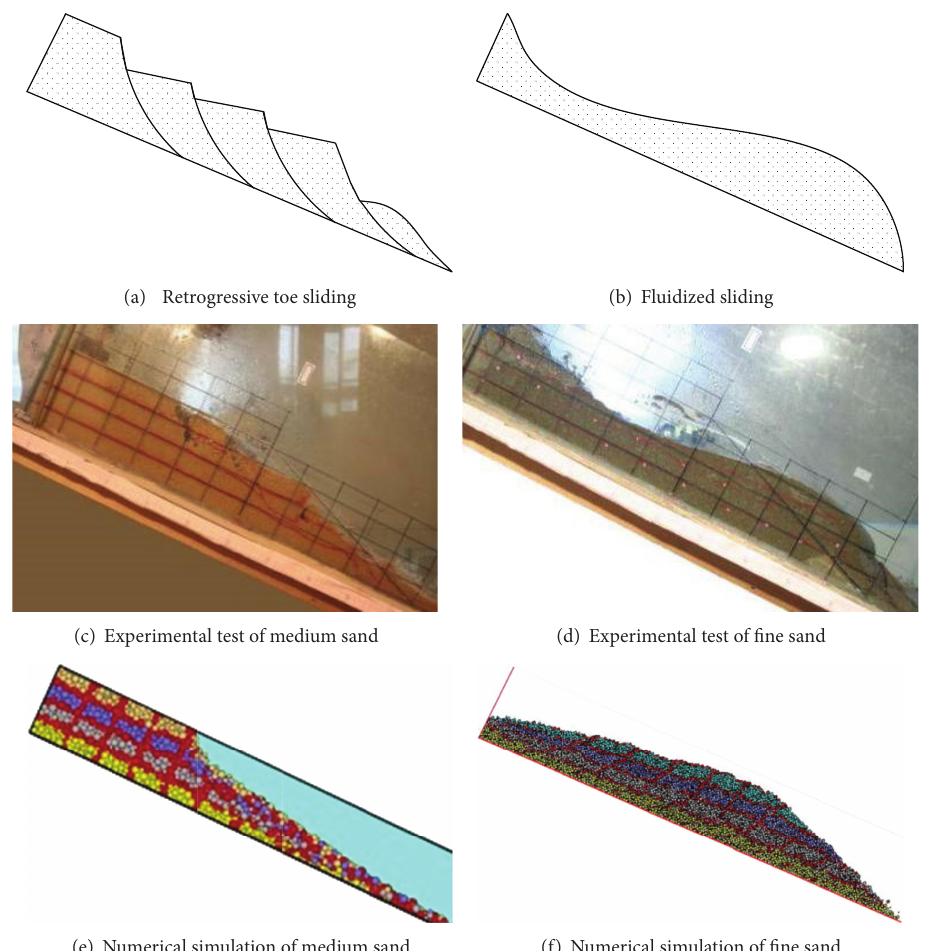
Figure 12: The failure mode of debris flow slope with medium sand or fine